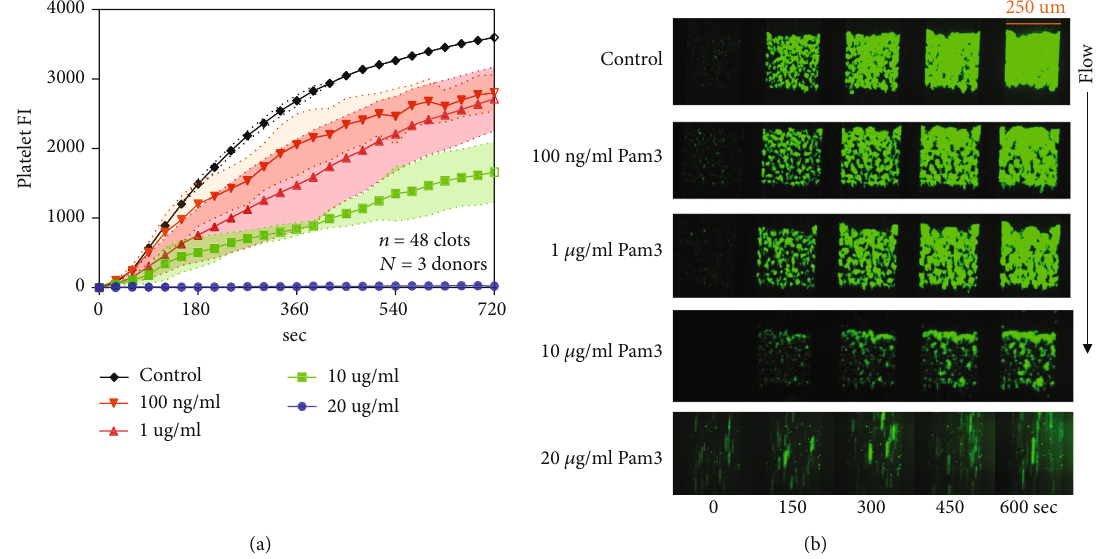
Figure 3: Pam3CSK4 dose dependently inhibit platelet deposition onto collagen under fl ow. PPACK WB treated with HBS (control) or di ff erent concentrations of Pam3CSK4 was perfused over collagen at 100 s -1 for 720 seconds. CD61 was added to all channels to label for platelets. Platelet FI was measured throughout the course of the experiments (a) and Figure 3(b) shows how they looked under the